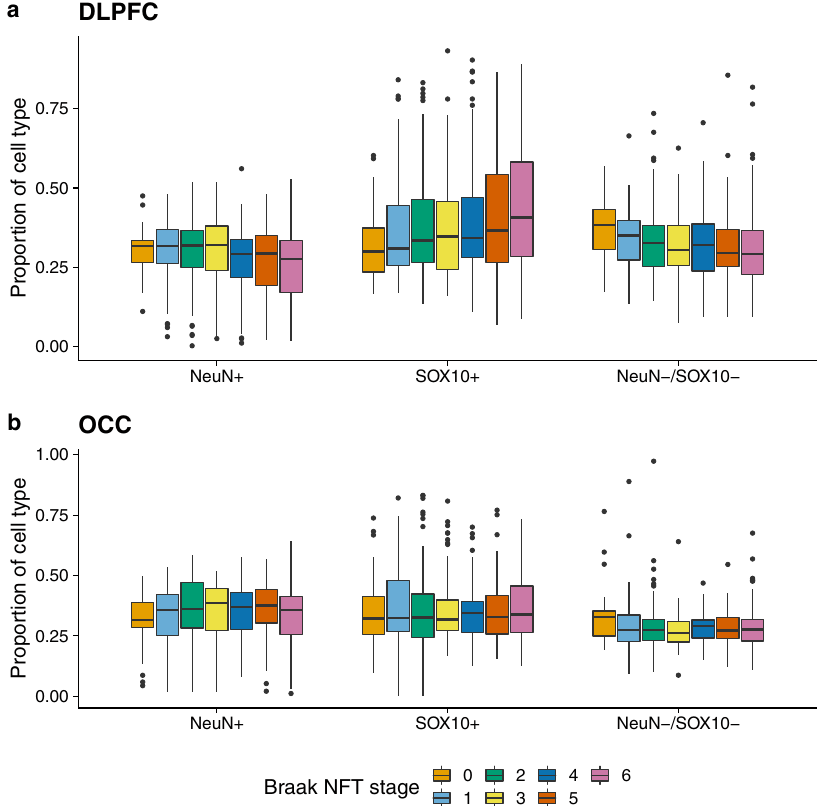
Fig. 1 | Elevated tau pathology is associated with cell proportion estimates derivedfromDNAmethylationdataintheDLPFCbutnottheOCC. Usinglinear regression models controlling for major covariates (see Methods) we show that a levels of tau pathology (measured using Braak NFT stage) are signi fi cantly asso- ciated with the proportion of NeuN+ cells (effect size= − 2.74,